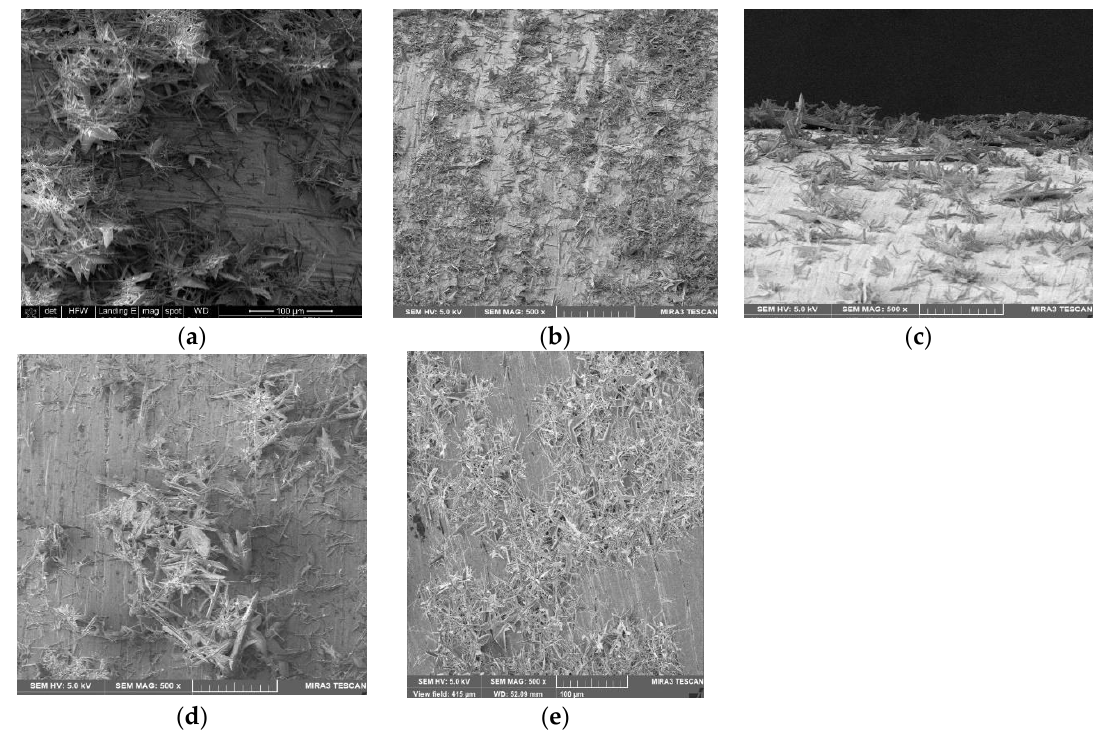
Figure 11. Micrographs of the scaled tube ( a ) control experiment, ( b ) C S = 0.04 g/L , ( c ) C S = 0.25 g/L, ( d ) C S = 0.50 g/L, ( e ) C S = 1.0 g/L. Scale bar = 100 µm.